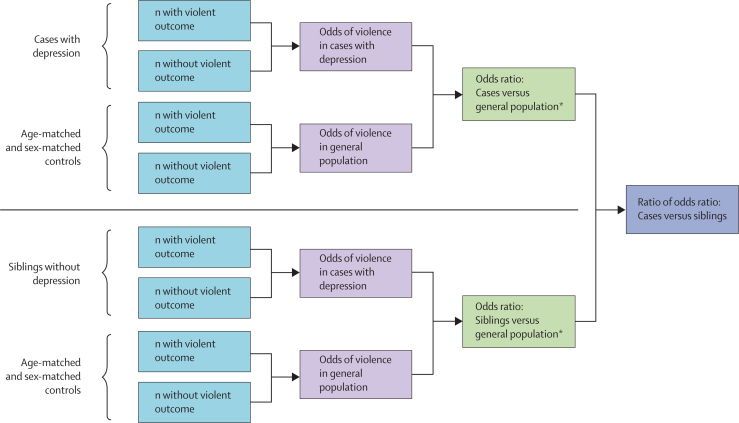
Ratio of odds ration=number. *Adjusted for low family income and born abroad.